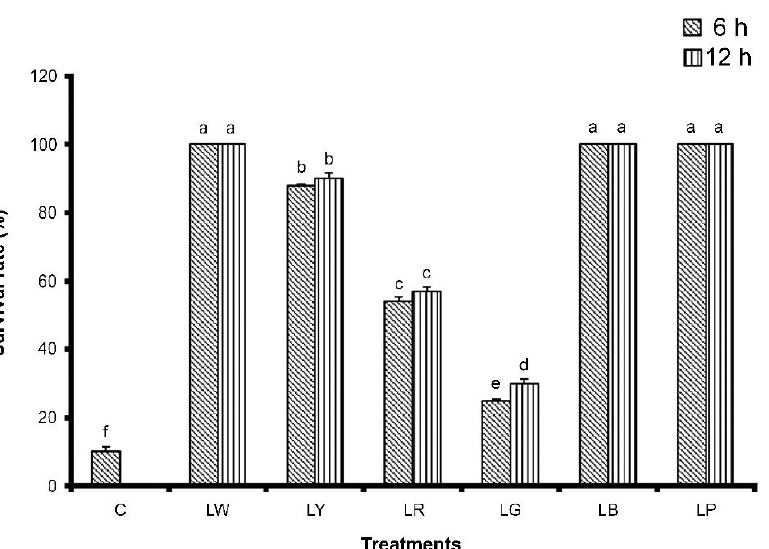
Figure 4. Survival of Goniopora columna after illumination under different light sources. Goniopora columna specimens were exposed to LW (444 – 696 nm), LG (500 – 540 nm), LY (570 – 590 nm), LB (440 – 470 nm), LR (620 – 650 nm), or LP (400 – 430 nm) light for 6 or 12 h per day over 8 weeks. The survival rates were calculated. Different letters indicate significant differences among groups ( p < 0.05). Values are expressed as means ± standard deviations ( n = 30).